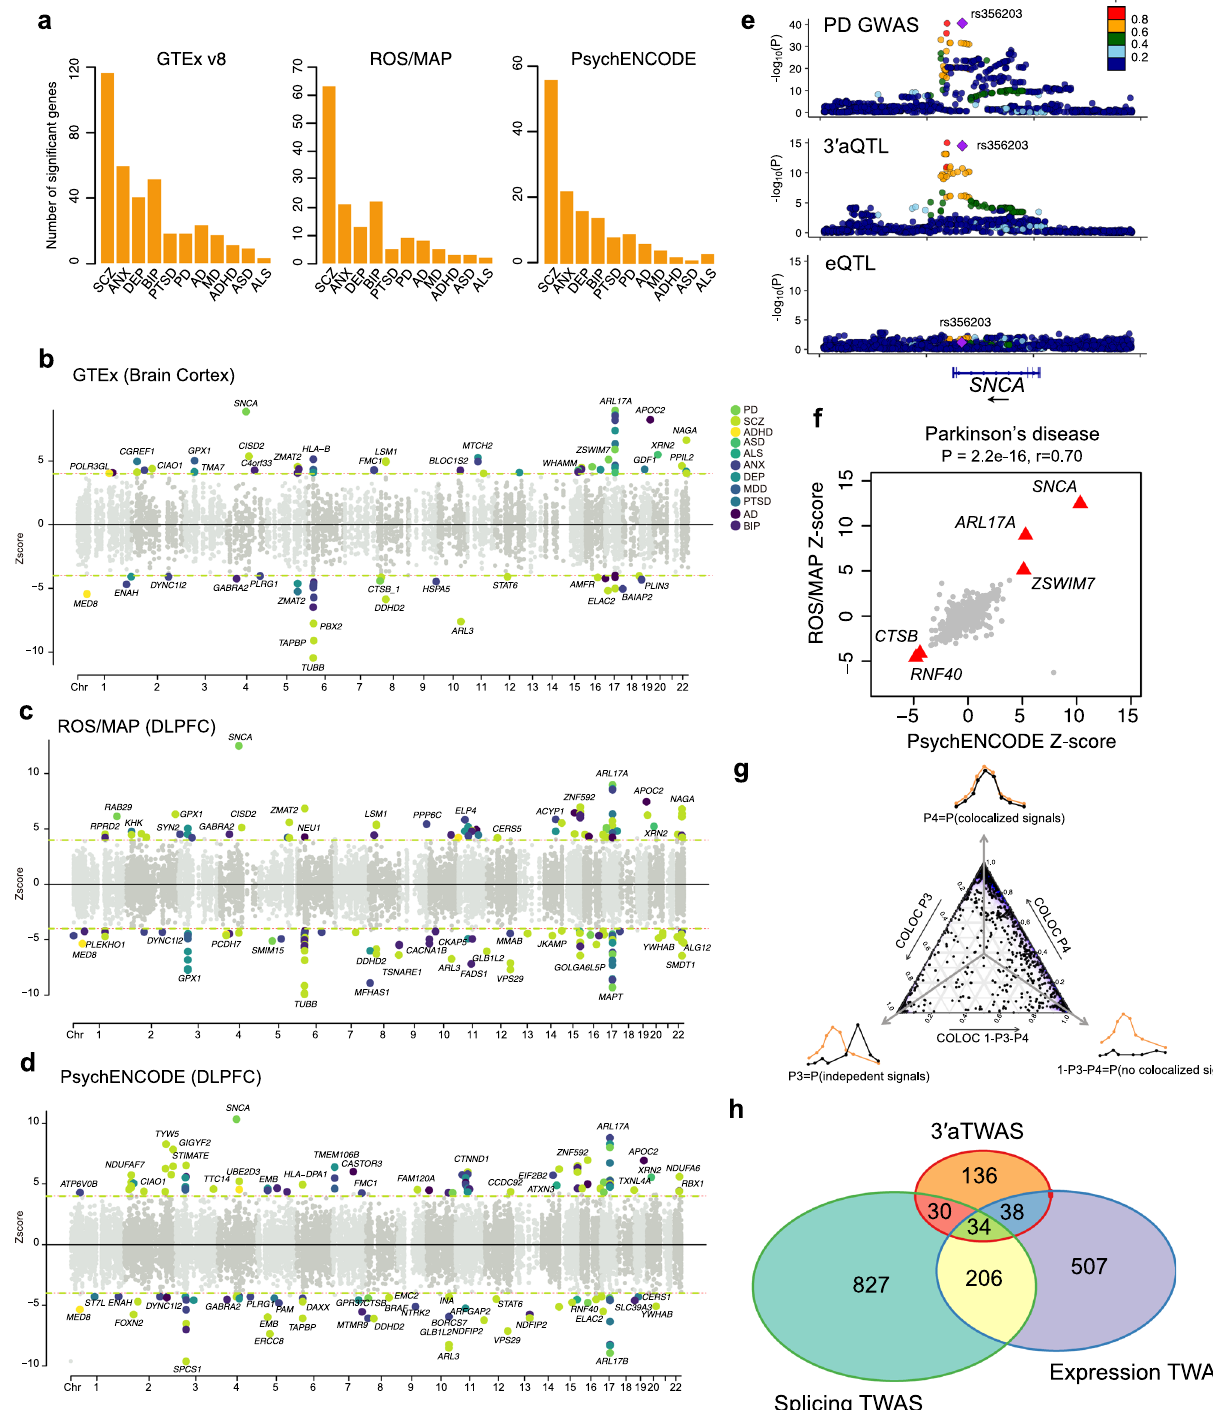
Fig. 4 | 3 ′ aTWAS for 11 brain disorders. a Bar plots show the number of 3 ′ aTWAS signi fi cant genes (FDR<0.05) for 11 brain disorders in 13 GTEx-derived brain tis- sues, ROS/MAP DLPFC, and PsychENCODE DLPFC. b – d Manhattan plots of 3 ′ aTWAS results in 11 brain disorders using prediction models from GTEx Brain Cortex ( b ), ROS/MAP DLPFC ( c ), and PsychENCODE DLPFC ( d ). Each point repre- sents the Z -score of a single 3 ′ aTWAS association. Colored points represent sig- ni fi cant associations with brain disorders at FDR<0.05, with each of the 11 colors representing 1 of 11 different brain disorders. e Aligned Manhattan plots of Par- kinson ’ sdiseaseGWAS,3 ′ aQTLs,andeQTLsatthe SNCA locus.SNPsarecoloredby LD ( r 2 ). f Parkinson ’ s disease was used as an example to assess whether similar